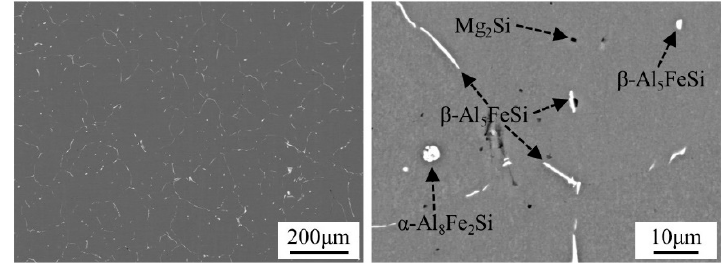
Figure 6. Primary phase morphology of as-cast